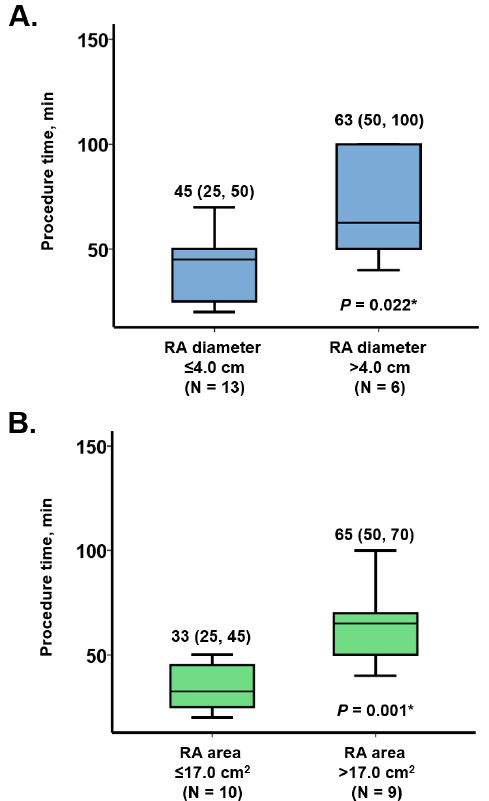
Figure 1. Receiver-operating characteristic curve for predicting procedure time > 60 min. ( A ) Receiver- operating characteristic curve of right atrial diameter. ( B ) Receiver-operating characteristic curve of right atrial area.